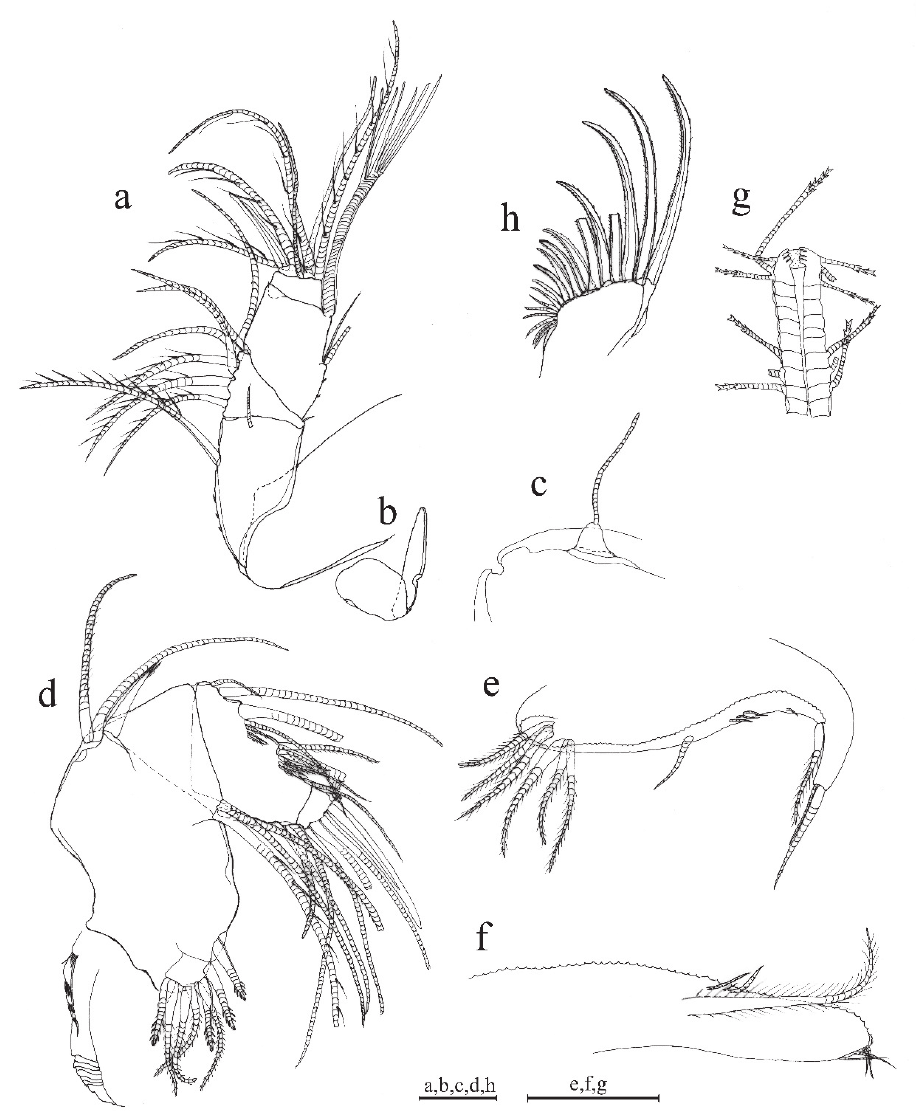
Figure 3. Parasterope busanensis sp. nov. holotype female adult: a A1 b Bellonci organ c A2 d Md e Mxl f L5 g L7 h F. Scale bar: 0.1